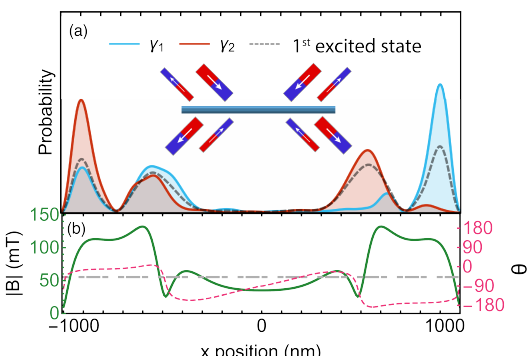
Figure 10: (a) Probability distributions for two lowest energy states, this system shows two overlapping and degenerate states with no clear Majorana polariza- tion and no higher energy state being gapped out. The energies of both states / ∆ = 3.9 × 10 − 2 and E / ∆ = 4.6 × 10 − 2 . (b) Field profile along wire. Exter- E 1 2 nal field is 40mT in positive y-direction.